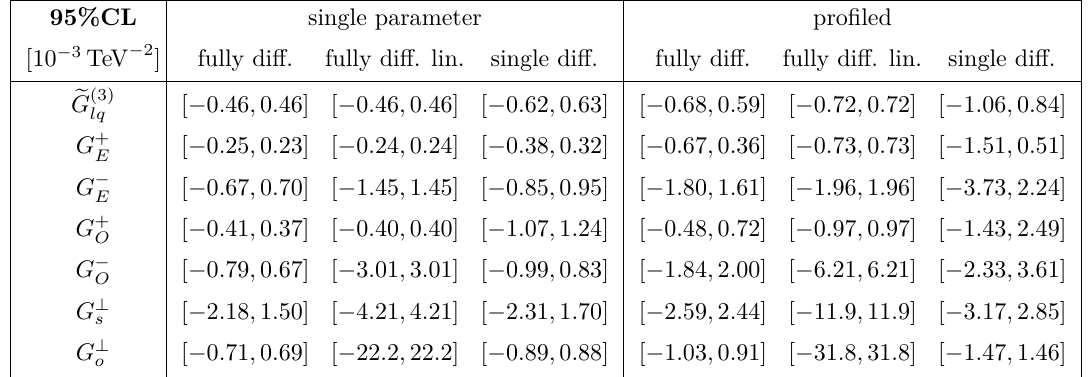
Table 4 . 95% CL projected bounds for the seven coefficients e G (3) 2% uncorrelated systematic uncertainty.